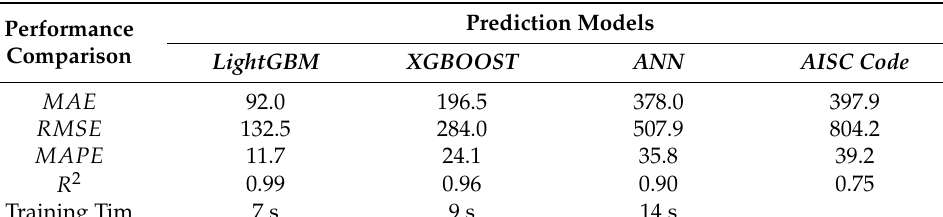
Table 4. Performance comparison for prediction of the ML models and AISC code.